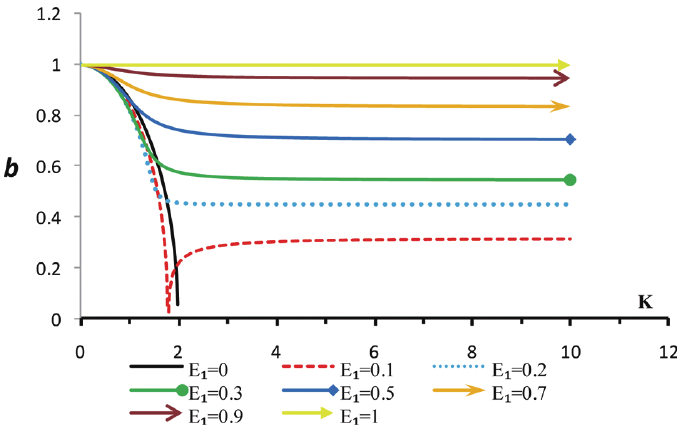
Fig. 4. Variations of b in terms of K for different values E 1